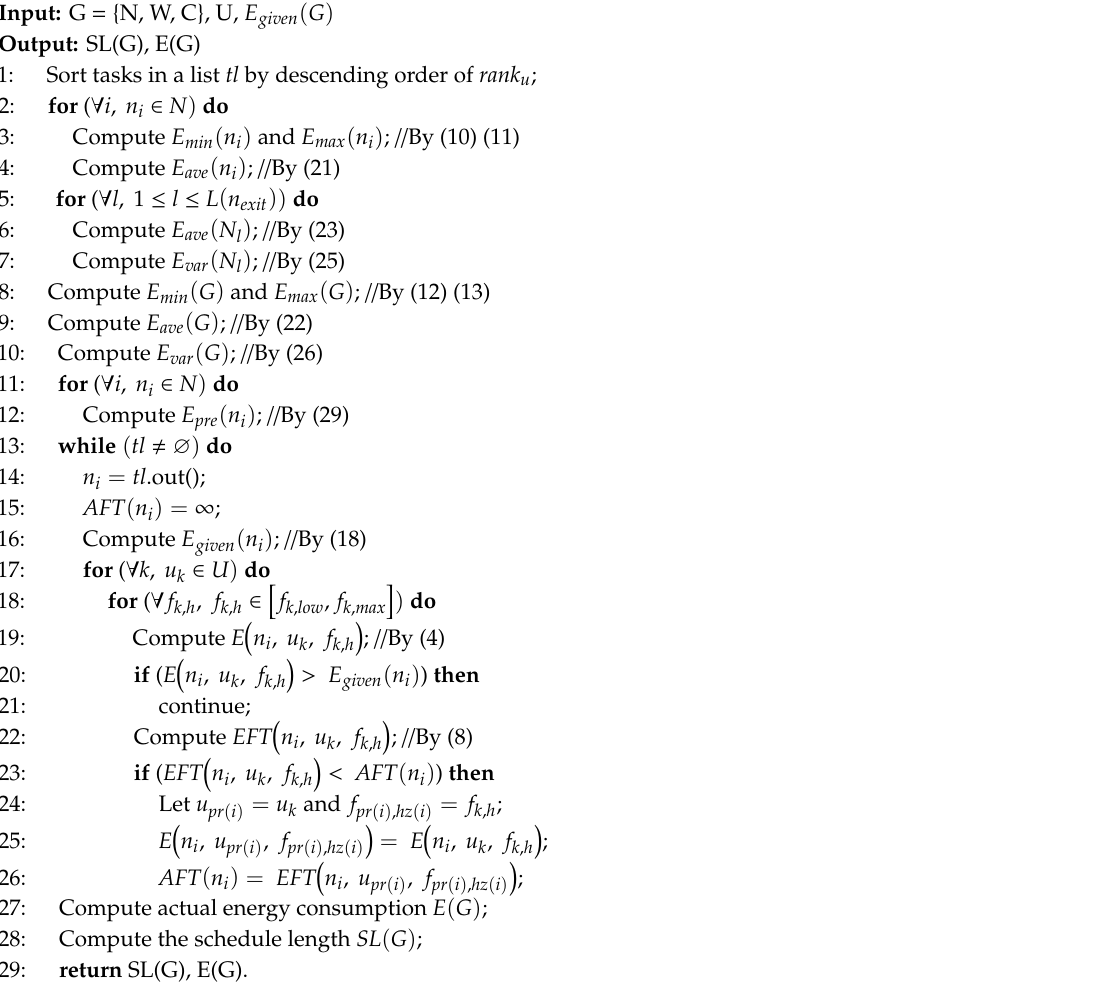
Algorithm 1. A new scheduling algorithm for minimizing schedule